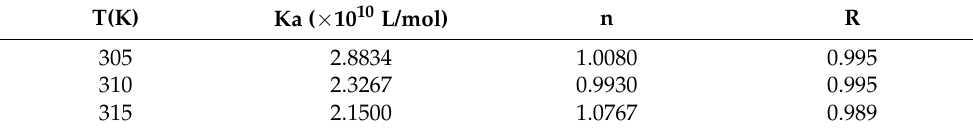
Figure 9. Double logarithmic curves ( A ) and the modified Stern–Volmer curves ( B ) of MAO-B fluorescence quenched by LB. Table 6. The binding sites (n) and the binding constant (K) of the inaction of MAO-B and LB.